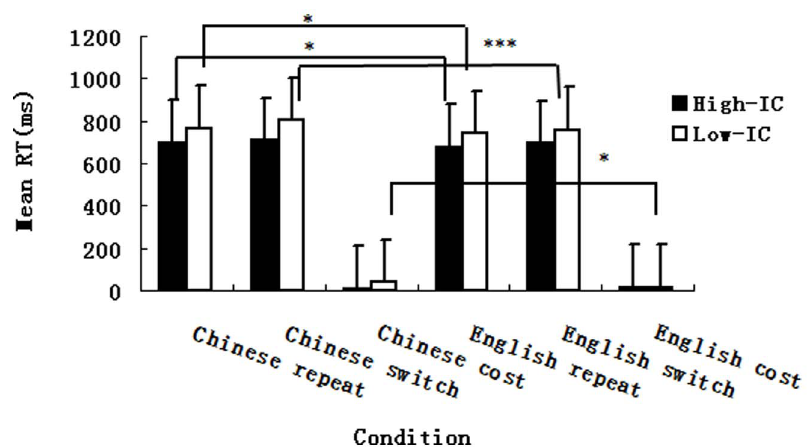
Figure 1. Mean latencies (ms), language switch costs, and standard errors for the high and low inhibitory control (IC) group during the EEG experiment.